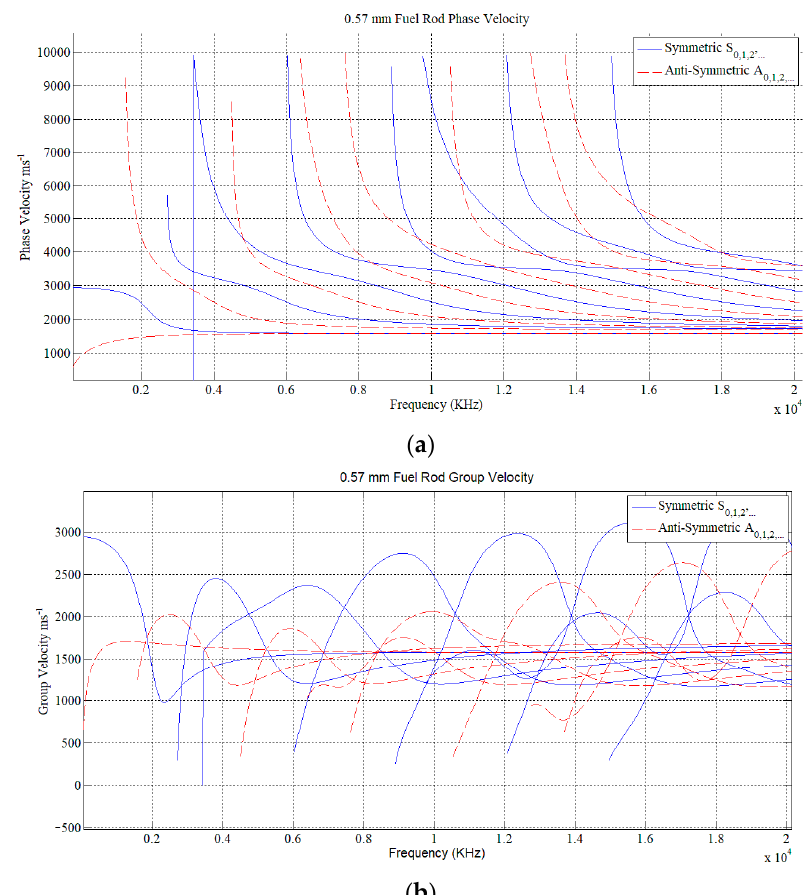
Figure 1. ( a ) the phase velocity; ( b ) the group velocity.